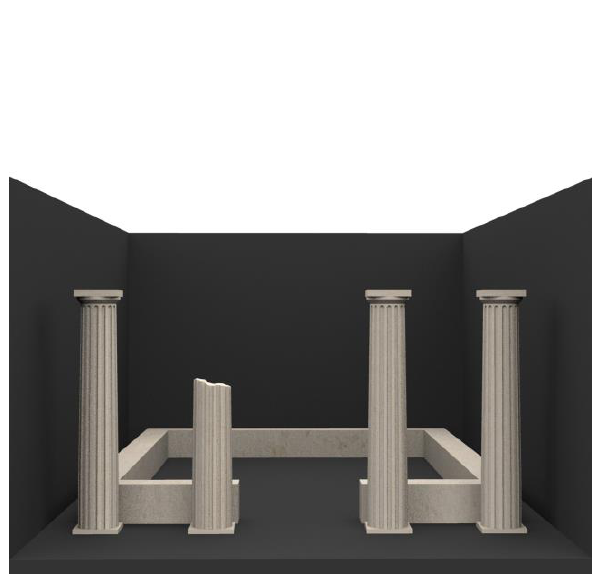
Figure 30. The Tomb of Persephores in Verghina. 3D model of the current state.